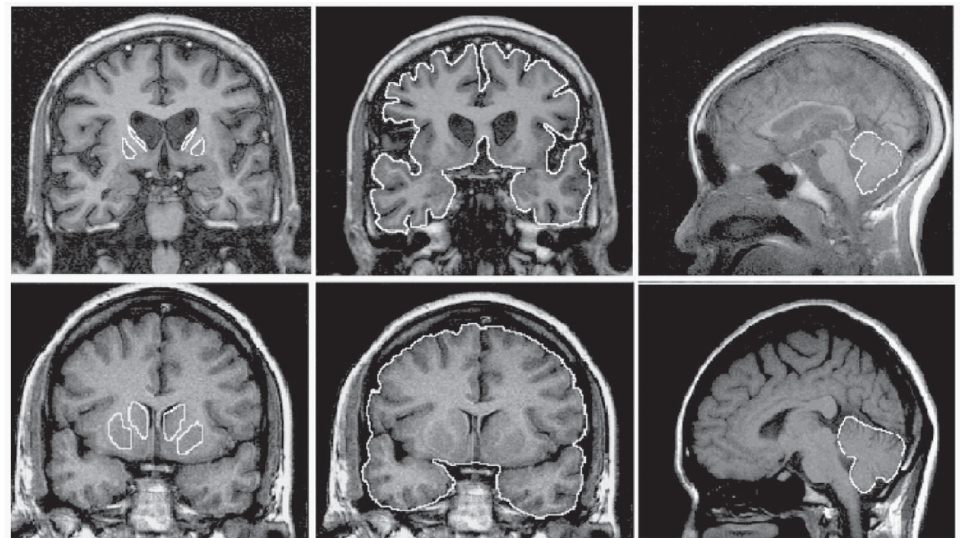
Figure 1. Samples of coronal and sagittal magnetic resonance imaging from a patient with Huntington’s disease (top row) and a normal control (bottom row) showing the outlines of cau- date and putamen (left), cere- bral (center) and cerebellar vol- umes